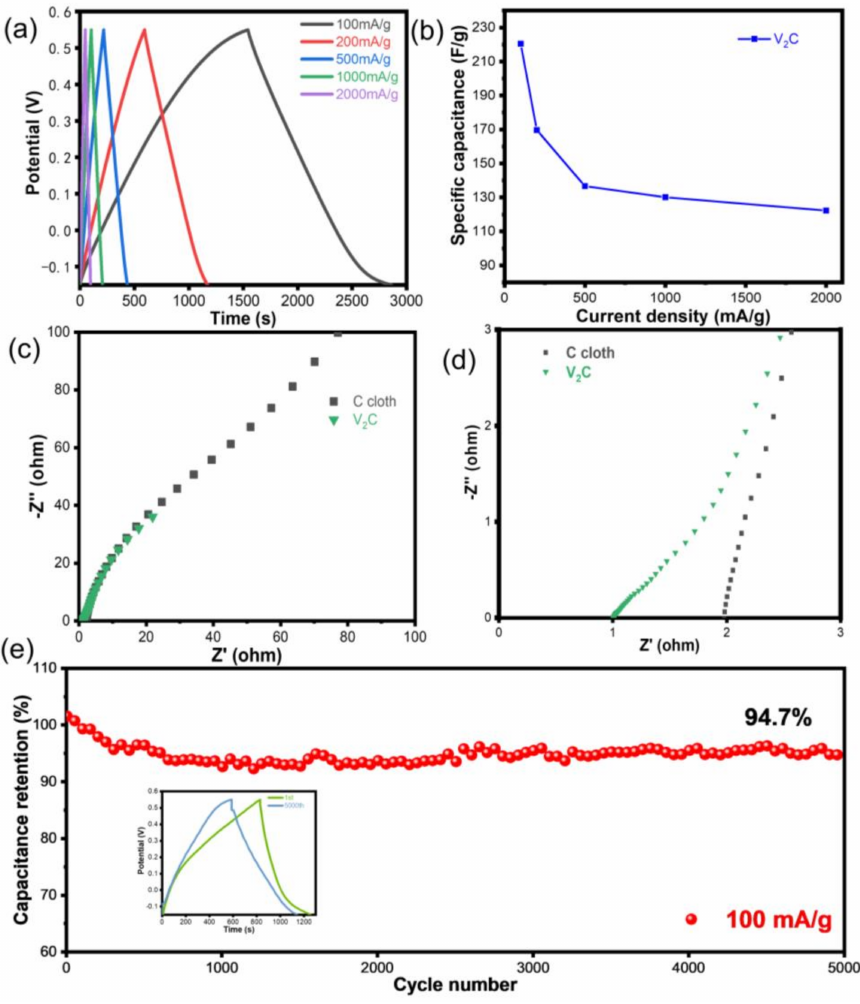
Figure 7. ( a ) GCD curves of V 2 C at different current densities in 1 M Na 2 SO 4 , ( b ) specific capacitance at different current densities, ( c ) Nyquist plots of V 2 C and carbon cloth, ( d ) magnified image of the Nyquist plots in the high frequency part, ( e ) cycling performance of V 2 C evaluated at 100